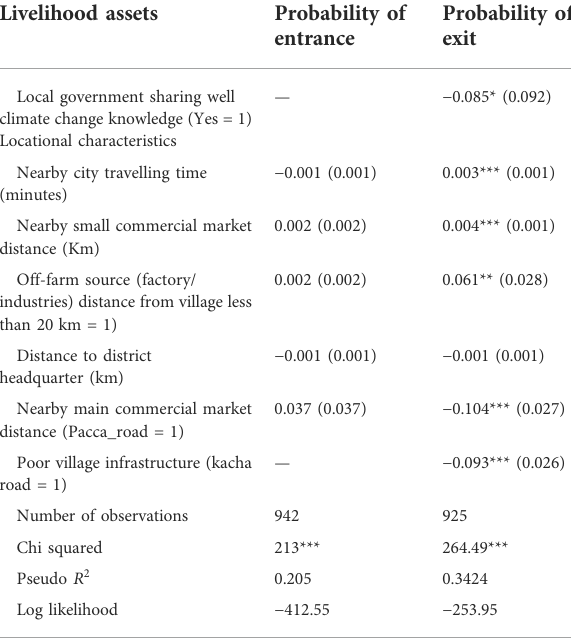
TABLE 3 Marginal effects of probit regression for the probability of entrance and exit into and from